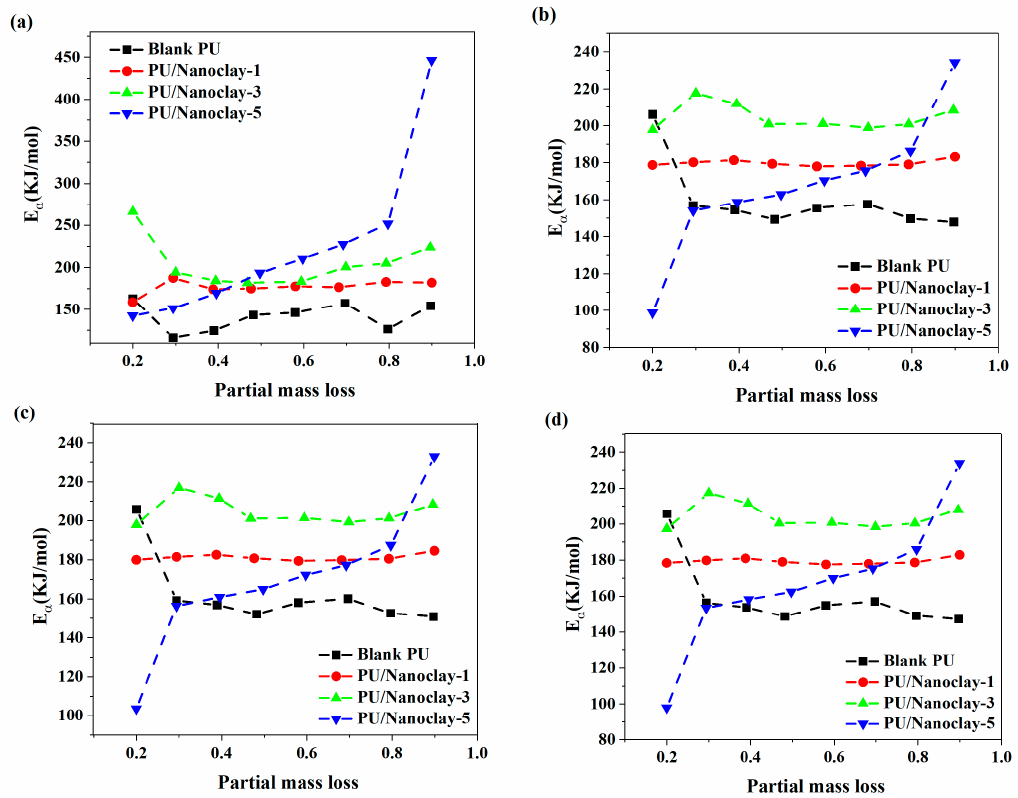
Figure 5. Activation energy of blank PU and its nanocomposites containing 1, 3, and 5 wt.% of nano-clay in terms of partial mass loss obtained using ( a ) Friedman ( b ) KAS , ( c ) FWO , and ( d ) m-CR methods.